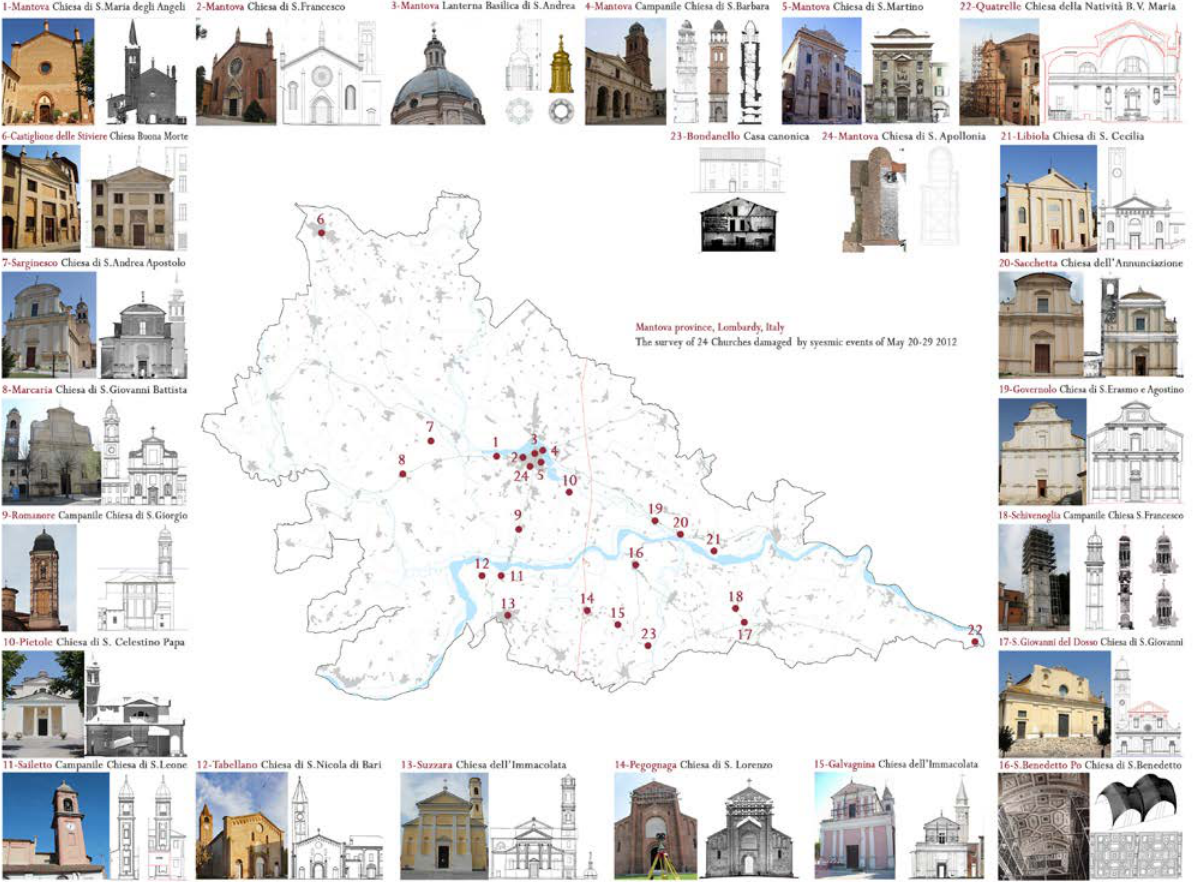
Figure 2. Mantua Province and the 24 buildings surveyed by Hesutech Laboratory of